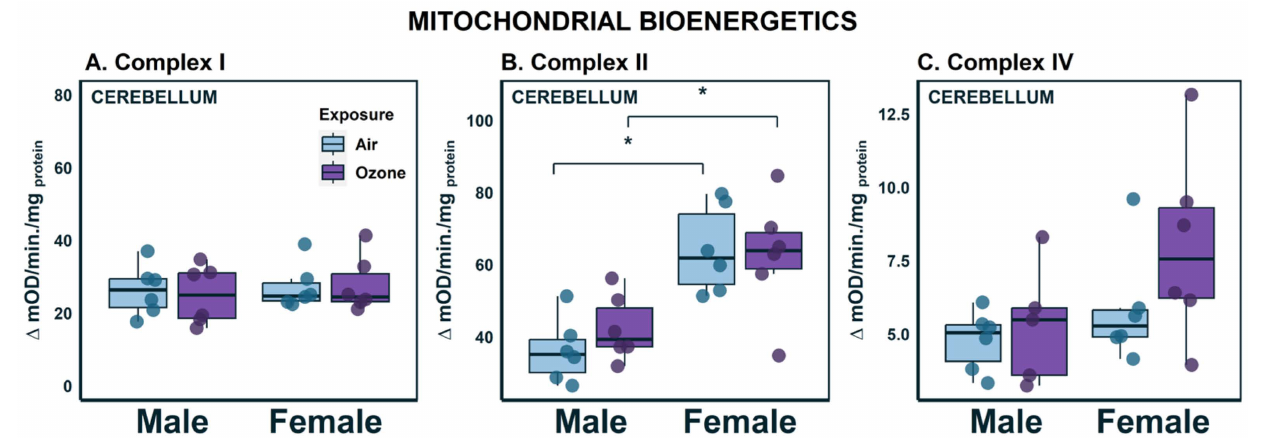
Figure 2. Mitochondrial complex enzyme activities in the cerebellum following ozone exposure in male and female rats. ( A ) Complex Enzyme I activity; ( B ) Complex Enzyme II activity; ( C ) Com- plex Enzyme IV activity. Data are represented by boxplots with a dot plot overlay to express the distribution of each datapoint where n = 6. * Statistical difference p <